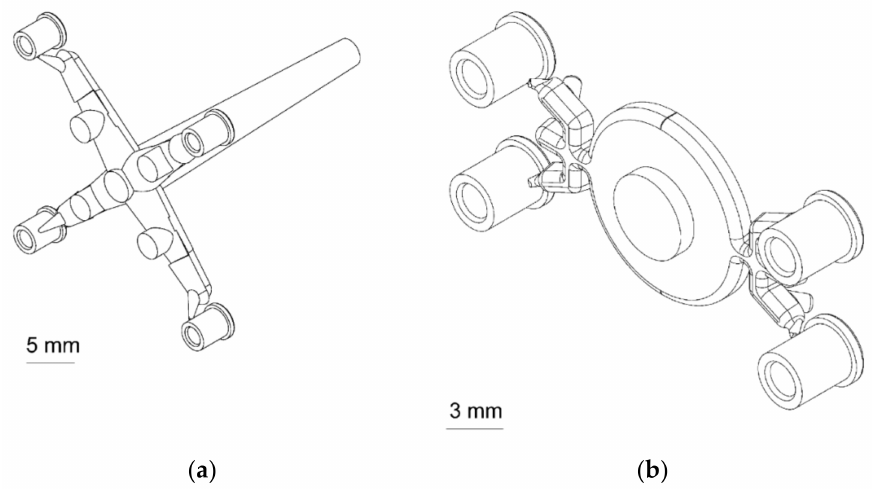
Figure 3. 3D view of the feed systems used with ( a ) the IM machine and ( b ) the µ IM machine. Reproduced with permission from [23].